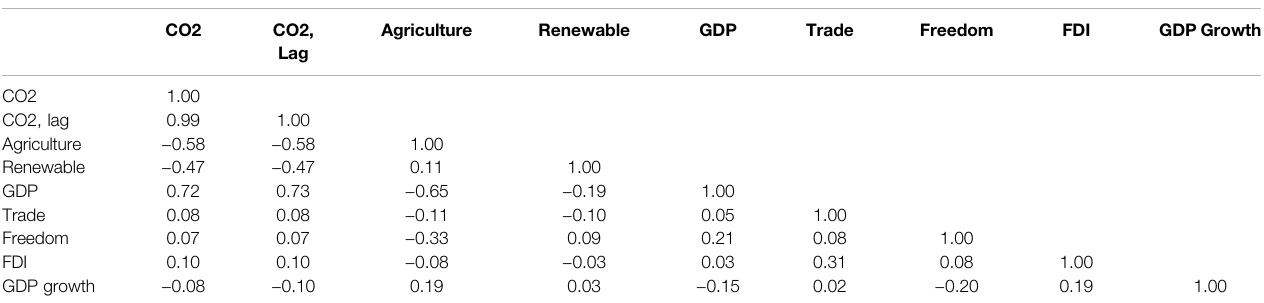
TABLE 2 | Correlation